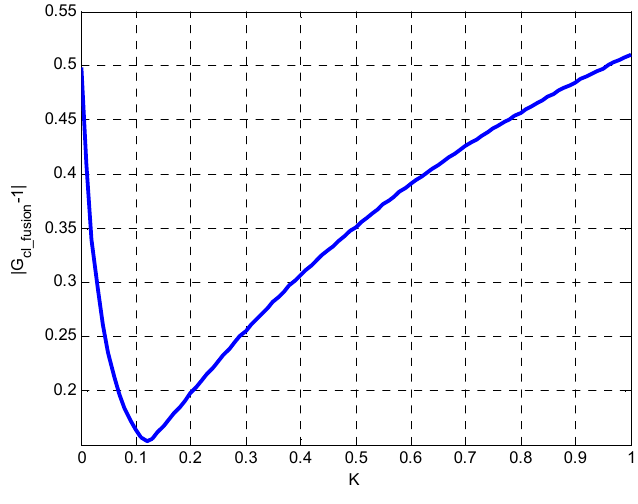
(cid:12) (cid:12) − 1 | when k is (cid:12) G cl _ fusion